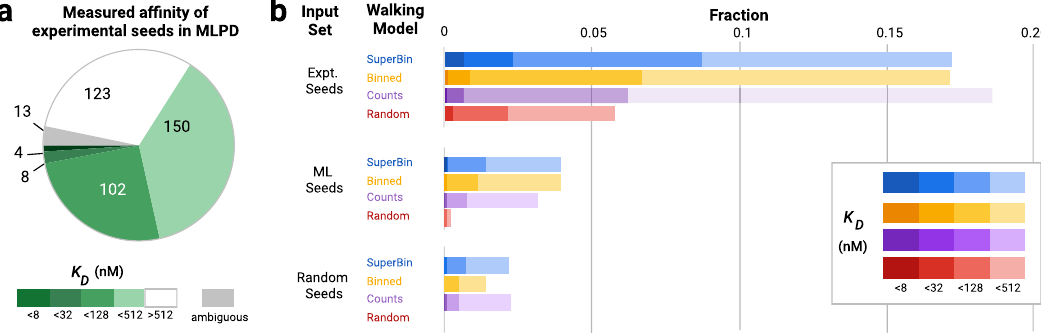
Fig. 3 Experimental validation of machine learning predictions. a Observed af fi nity for experimental seeds used in machine learning guided particle display (MLPD). Greens correspond to sequences at particular af fi nity thresholds (with darker greens indicating higher af fi nity); white corresponds to sequences below the lowest screened af fi nity, and gray corresponds to sequences with ambiguous af fi nity. b Candidates generated by three machine learning (ML) model walks (SuperBin (blue), Binned (orange), Counts (purple)) and Random walks (Red) as a fraction of the input pool size. The MLPD panels show ML-directed walks starting from (top) the original particle display experimental (expt.) seeds, (middle) randomly screened and model ranked ML seeds, (bottom) completely random seeds. Independent of the seed category, the ML-directed walks substantially outperform random walks and